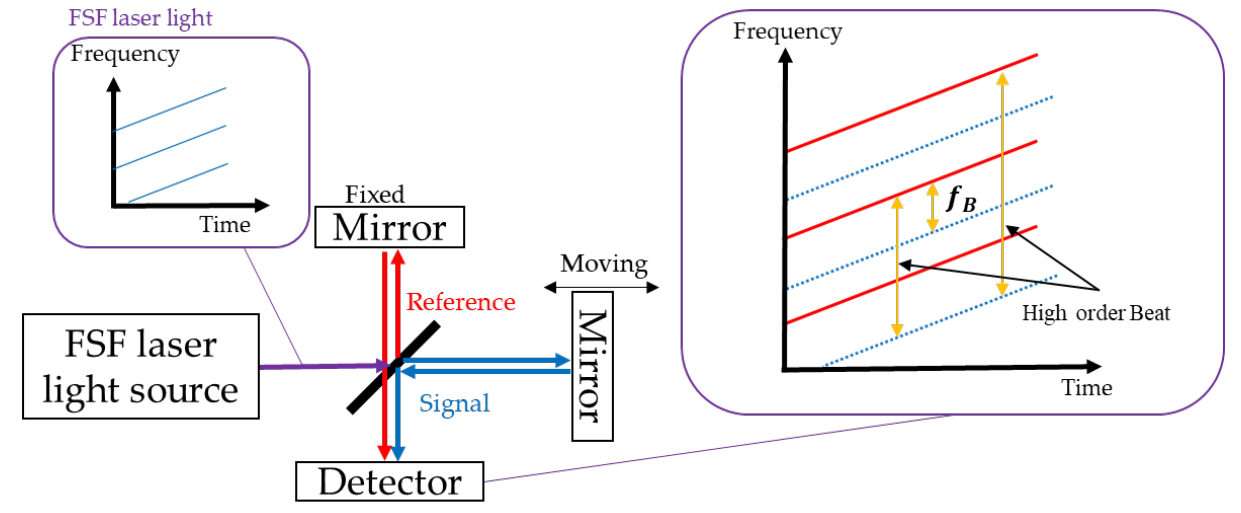
Figure 1. Schematic of a comb of chirped frequencies.